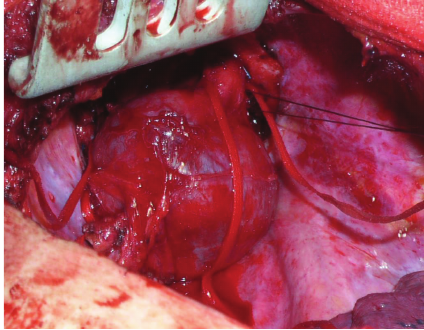
Figure 2: Intraoperatively, the tumour was found to originate from the posterior cord of the brachial plexus.